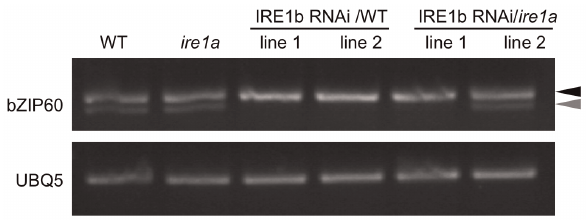
Figure 2. Expression of IRE1b transcript in RNAi lines. Quantification by qRT-PCR of IRE1b transcripts relative to the Ubiquitin 5 reference gene in 8 d-old seedlings in lines expressing the IRE1b RNAi construct in WT and ire1a mutant backgrounds. Two WT controls are displayed on the graph to account for the data obtained in separate assays. Two independent lines are shown for each transformed construct. Error bars=SE.